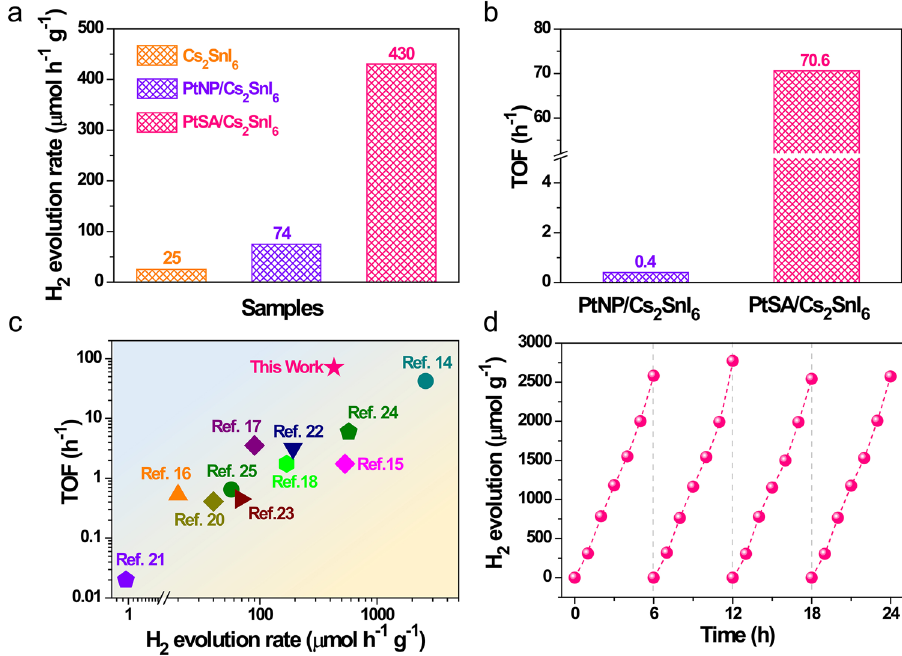
Fig. 3 Superior photocatalytic activity and stability of PtSA/Cs 2 SnI 6 catalyst. a The rate of photocatalytic H 2 evolution over PtSA/Cs 2 SnI 6 , PtNP/ Cs 2 SnI 6 , and Cs 2 SnI 6 catalysts. b TOF of PtSA/Cs 2 SnI 6 and PtNP/Cs 2 SnI 6 catalysts. c TOF comparisons of PtSA/Cs 2 SnI 6 catalyst and other reported Pt- loaded halide perovskite photocatalysts. d Cyclic stability of the PtSA/Cs 2 SnI 6